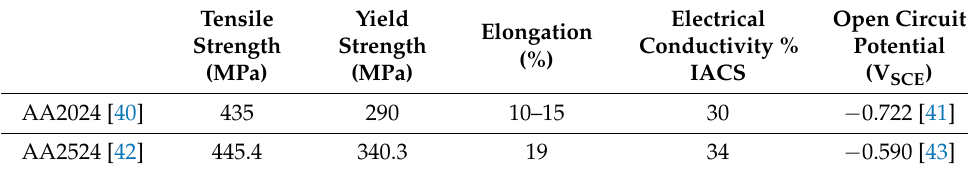
Table 2. Mechanical and corrosion properties of the AA2024-T3 and AA2524-T3 alloys.